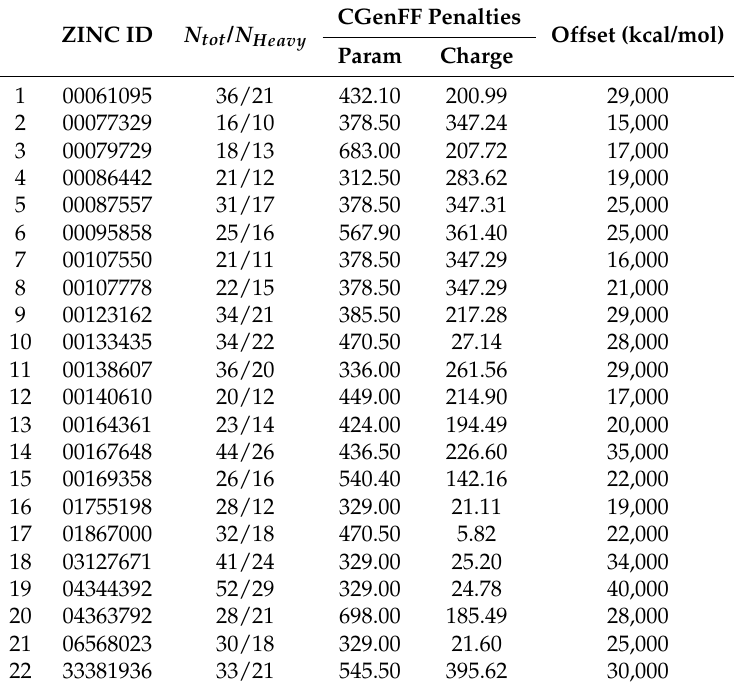
Table 1. ZINC Database ID’s for each HiPen molecule; the total number of atoms ( N tot ) and total number of heavy atoms ( N heavy ) per molecule; ParamChem reported CGenFF penalties; calculated ∆ A “offset” for each molecule in the dataset should be added or subtracted (to positive and negative ∆ A ’s respectively) to every ∆ A listed in Tables 2 and 3 to give the total calculated ∆ A